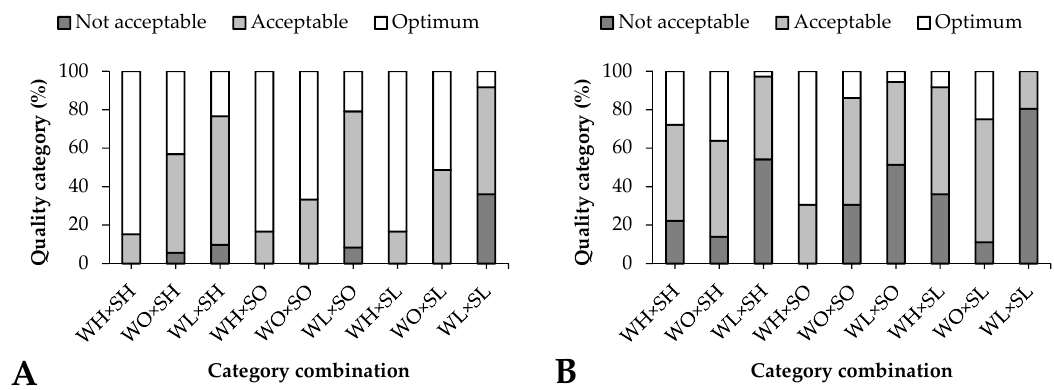
Figure 1. Quality categories (%) of grafted watermelon seedlings from nine quality category combinations obtained 7 ( A ) or 14 ( B ) days after grafting, as described in Table 1. Each percentage was computed from three trays each having n = 72 seedlings.